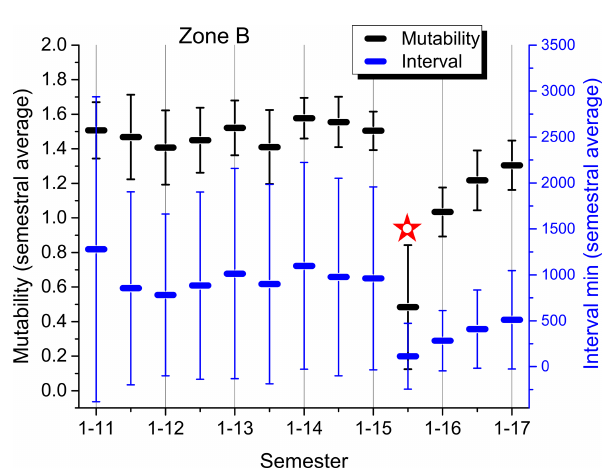
Figure 10. Semestral average of mutability values (upper sym- bols; black) and intervals in minutes between consecutive seisms (lower symbols; blue) for zone B (Illapel). Odd semesters are la- beled on the abscissa axis (1–13; first semester of 2013), while even semesters are only marked. A star identifies a semester with an earthquake with a magnitude over